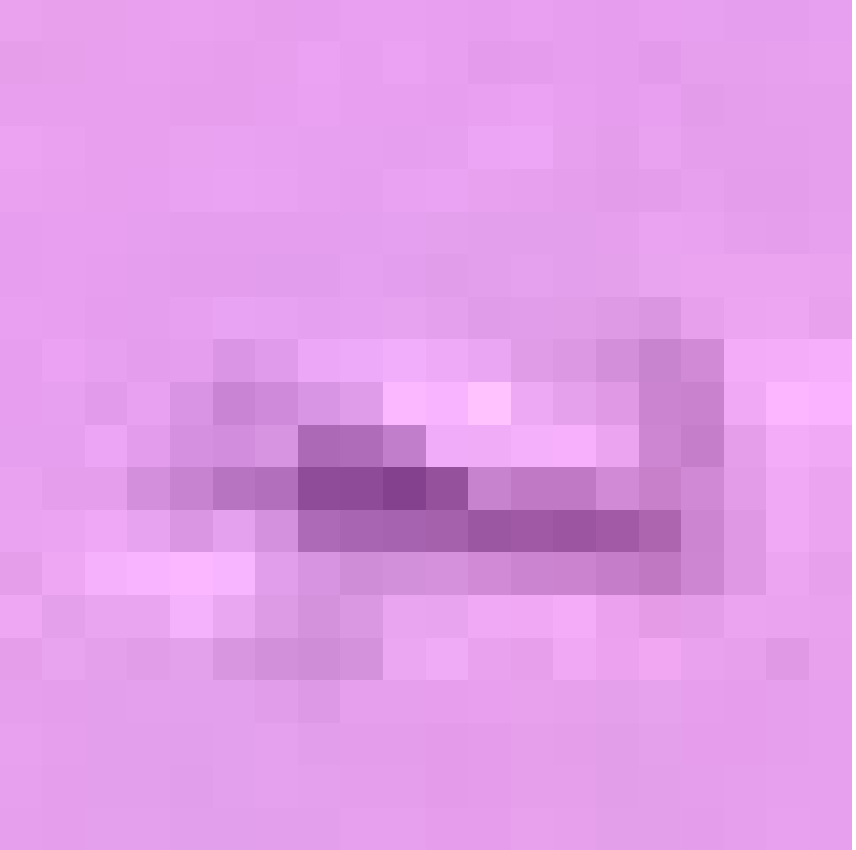
Figure 8. 20 × 20 region of interest